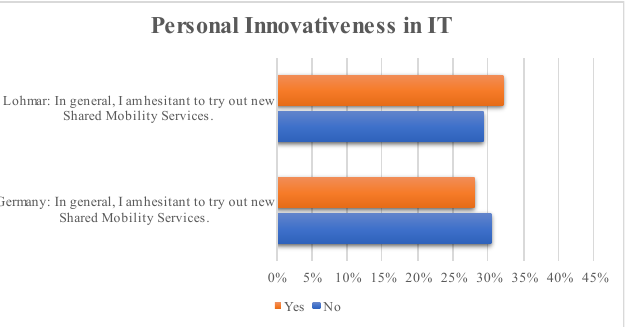
Figure 9. Personal Innovativeness in IT (PIIT): Germany vs. Lohmar.